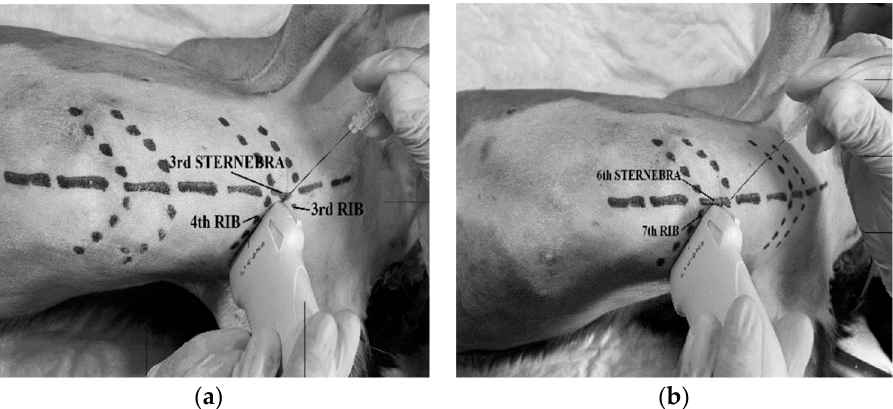
Figure 1. Two-point injection technique for the transverse approach to the transversus thoracis plane under ultrasound guidance. ( a ) The probe was placed parasternal and parallel to the third and fourth ribs, and the marker medially situated and guided from a caudo-lateral to cranio-medial orientation. The spinal needle was inserted from a ventro-medial to dorso-lateral direction using an “in-plane” technique. ( b ), Transducer positioned in the same orientation between the sixth and seventh ribs.